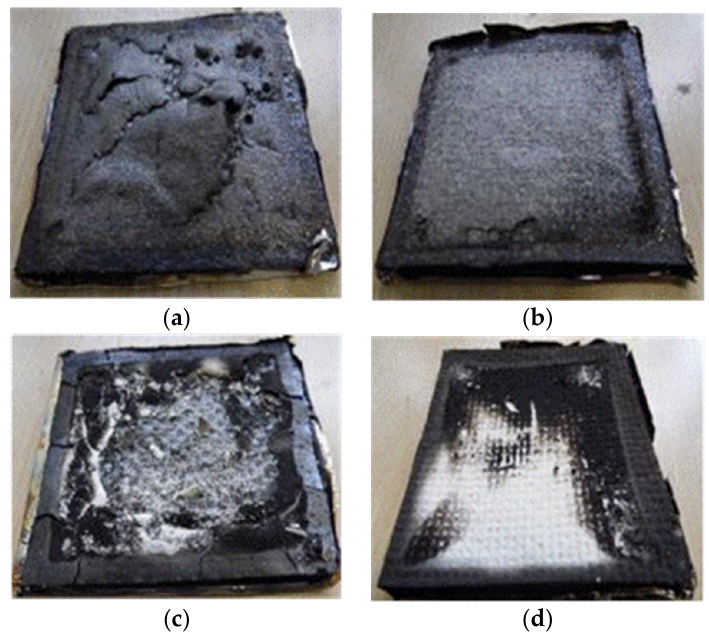
Figure 6. Digital images of the char residues of ( a ) CRE ‐ P/FlekS, ( b ) CRE ‐ Semi/Flek, ( c ) CRE ‐ P/ReS and ( d ) CRE ‐ Semi/Re samples after the cone test at 50 kW/m 2 heat flux.